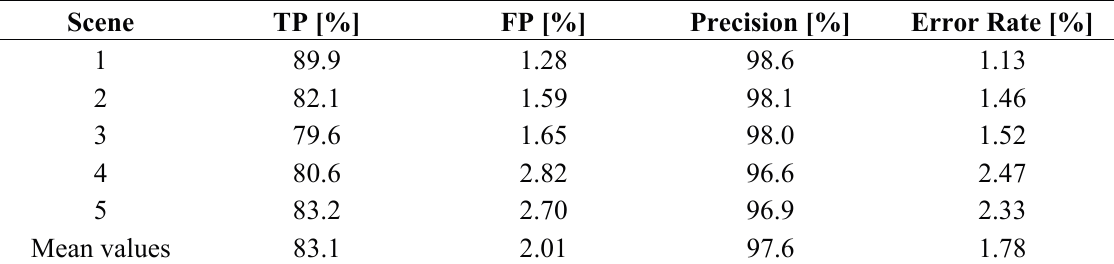
Table 5. Performance evaluation for vineyard